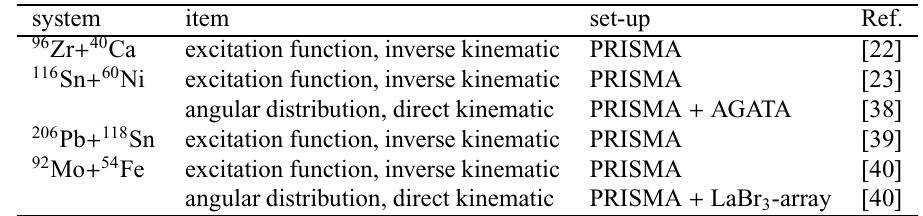
Table 1. Systems studied with PRISMA, in stand-alone or coupled to a γ array, employing inverse or direct kinematics